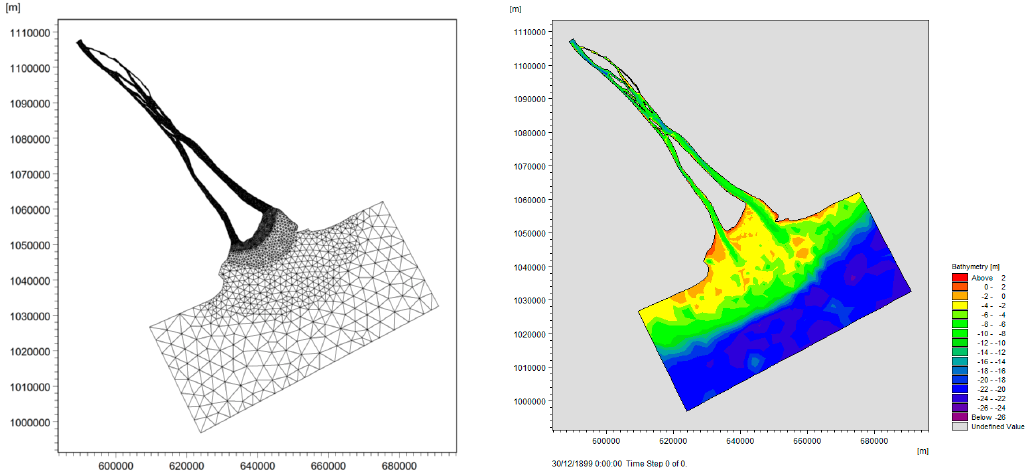
Figure 3. Bathymetry ( left panel) and computational flexible grid mesh ( right panel).